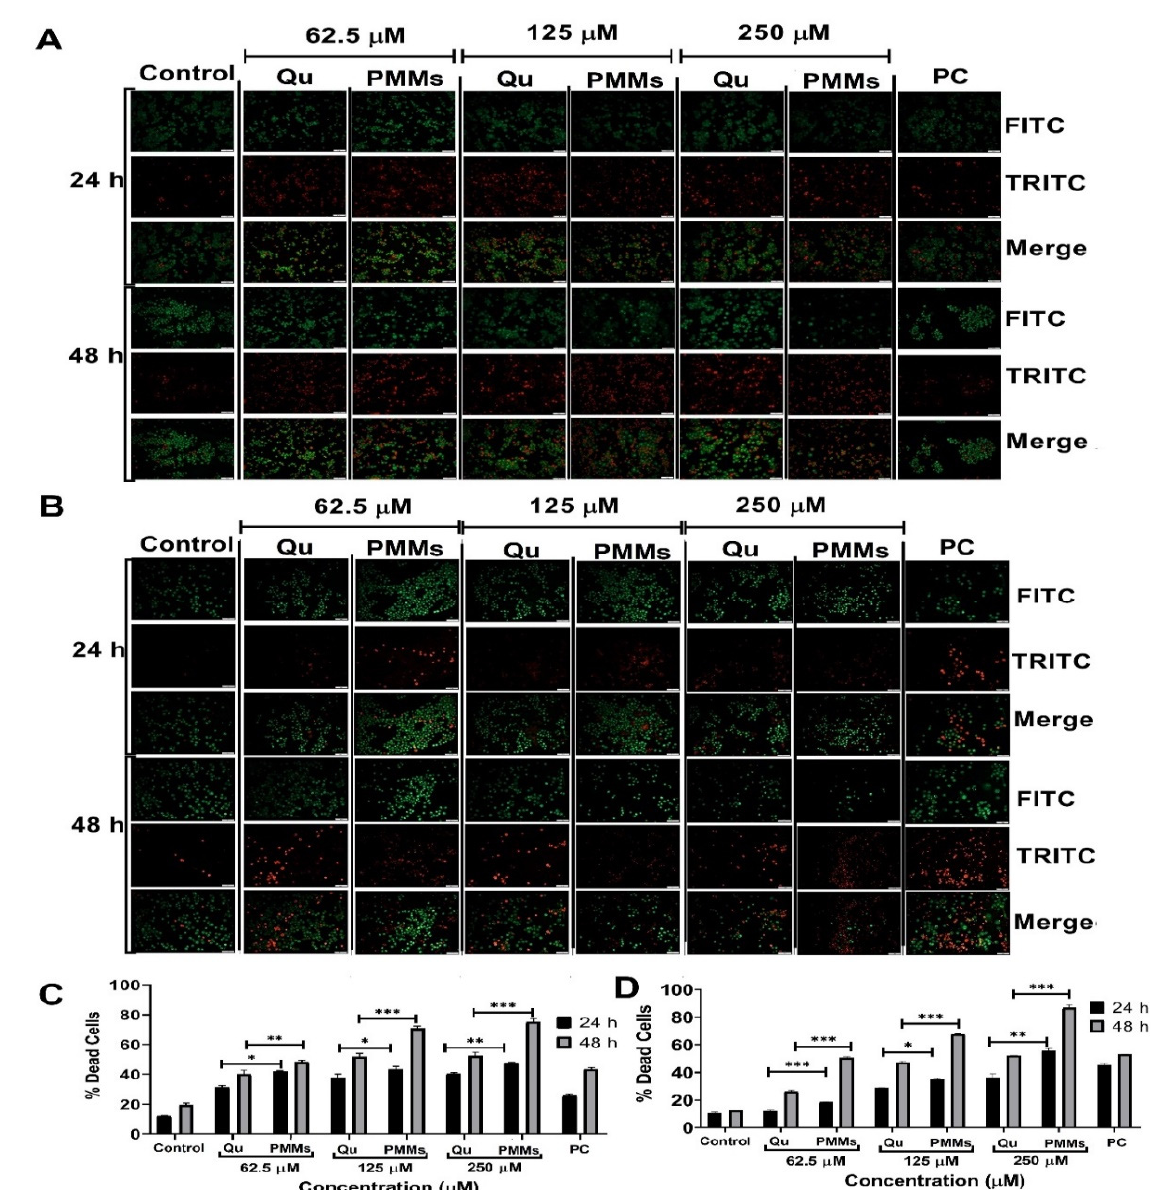
Figure 5. C6 and U87MG cells Apoptosis Assay. A. Pictorial representation of morphological changes of U87MG ( A ) and C6 ( B ) cells on the treatment of Qu and Qu-PMMs; The graphical representation of % apoptosis of U87MG ( C ) and C6 ( D ) cells treated Qu and Qu-PMMs time (24 h and 48 h) and dose (62.5, 125, and 250 μ M) dependent migration study by wound healing assays. Data are represented in means ± Standard deviation ( n = 3). * Indicates p ˂ 0.05, ** represents p ˂ 0.01 and *** represents p ˂ 0.001 (Qu PD vs. Qu-PMMs). Scale bar A (10×) 50 μ m and B (20×) 100 μ m.